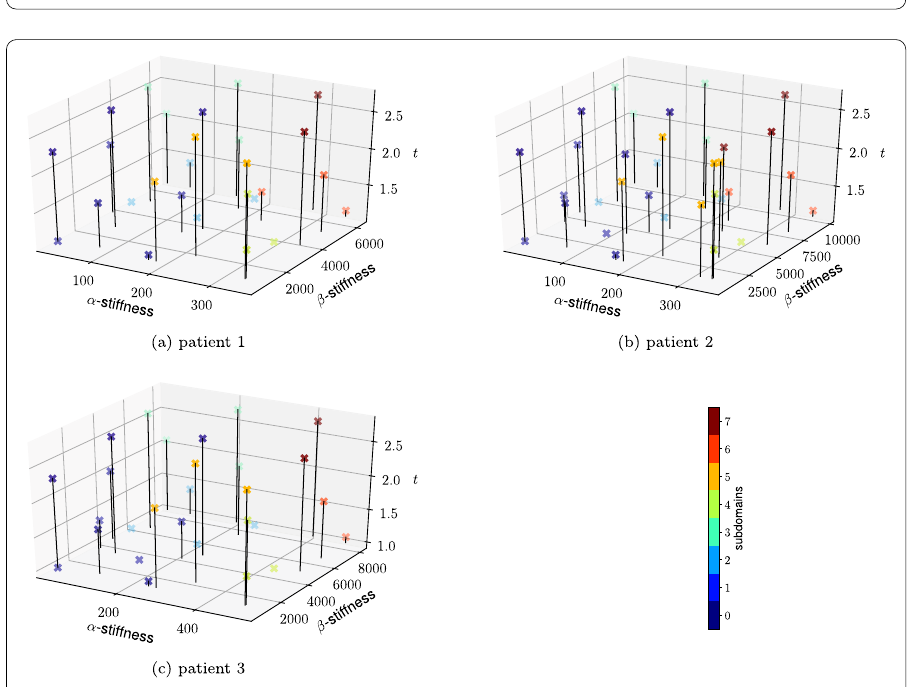
Fig. 8 Decay of SAD throughout parameter domain sampling. The parameter domain is subdivided into eight subdomains. The stopping criterion is a SAD below 0.1 in each subdomain. Corresponding point distributions in the parameter domain are depicted in Fig. 9